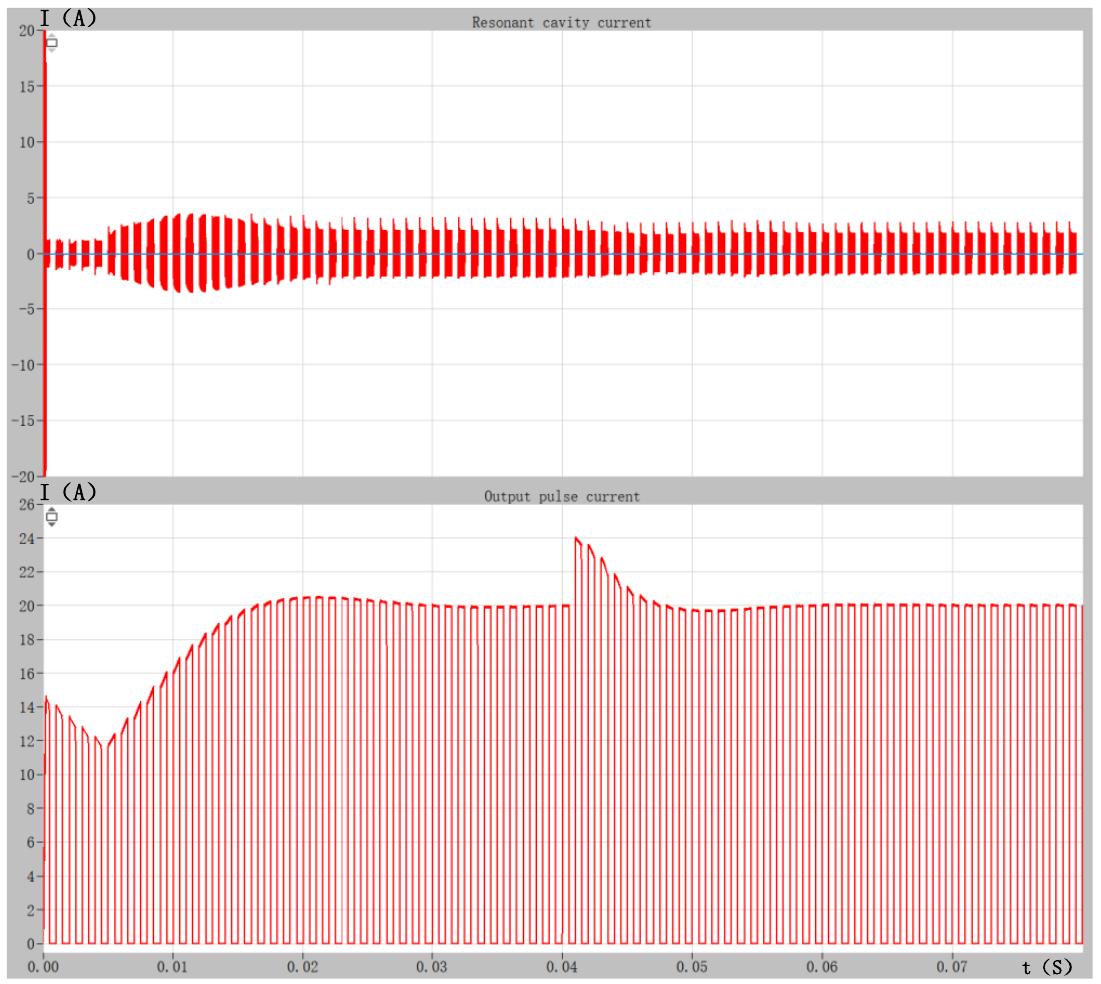
Figure 6 is the waveform diagram of pulse current intelligent PI closed-loop control under digital closed-loop simulation. The first waveform is the voltage and current wave- form of the LLC resonant cavity. There is no voltage and current in the resonant cavity during the pulse off period, indicating that the PWM is turned off; the second waveform is the output pulse current waveform. Load interference is added at 0.041s in the model. It can be seen that the output current returns to the set 20 A within 10 ms, which is very stable without a pulse spike; the third waveform is the count value corresponding to the drive frequency.